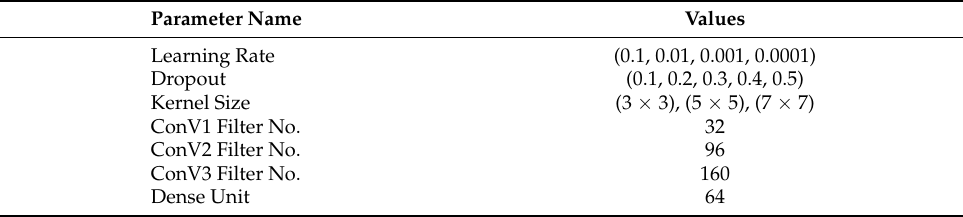
Table 1. List of networks’ parameters together with their